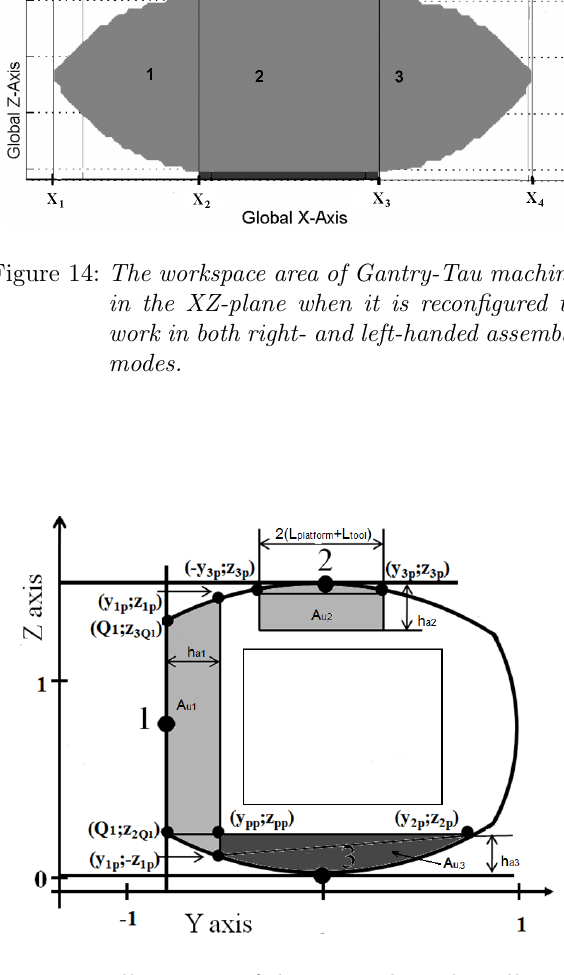
Figure 15: Illustration of the areas where the collisions between the platform and support frame are detected (grey areas). Square in the middle is the user’s specified workspace.